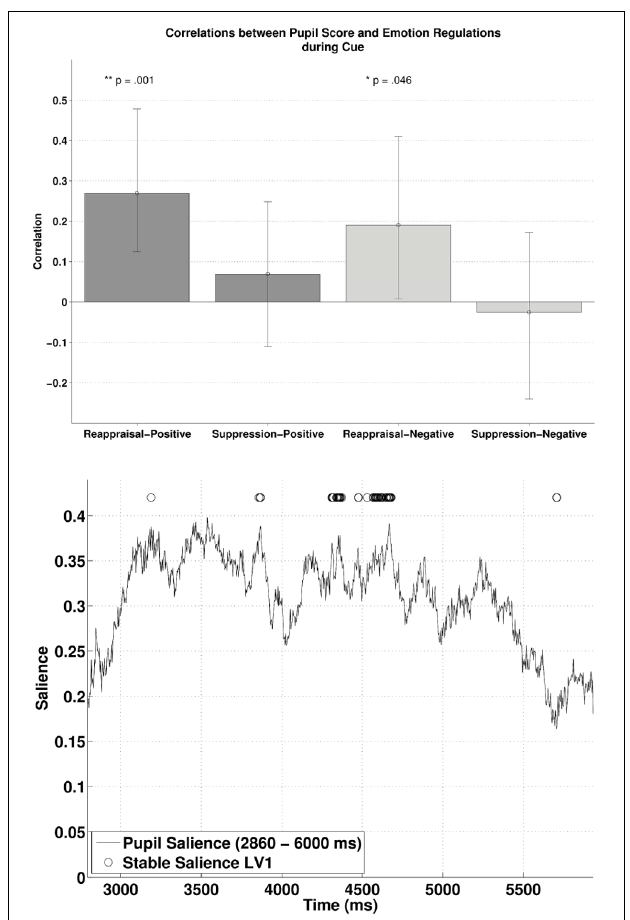
FIGURE 2 | The upper panel shows the line plot illustrating the changes in baseline-adjusted pupil diameters from cue to picture of individual participants. Regardless of emotion (left: positive, right: negative), pupillary changes tended to have opposite signs during the two stages of stimulus presentation, explaining the inverse correlations. The lower panel shows the scatterplots between mean pupil sizes during cue and picture when the Emotion of the trials was positive (left) and negative (right).